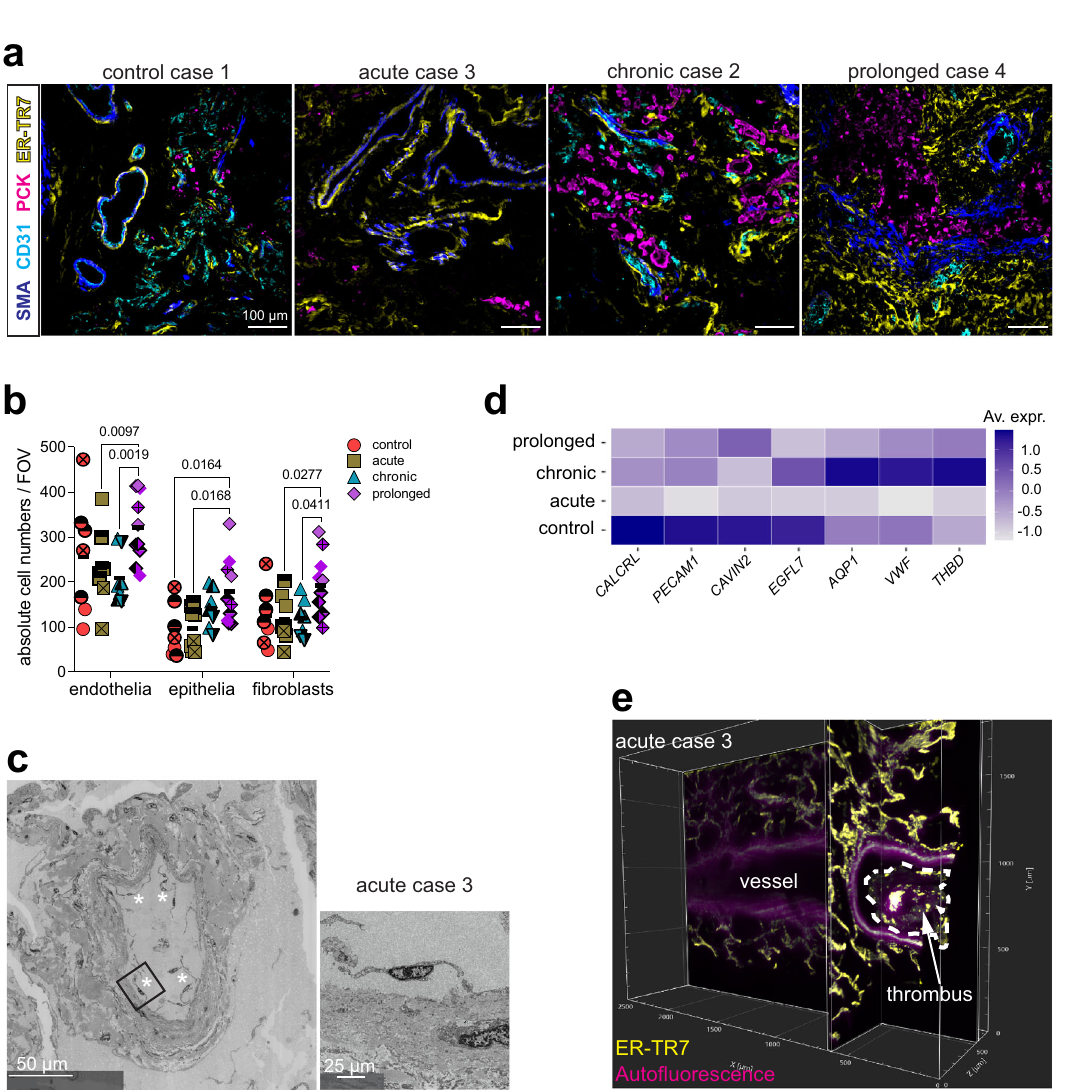
Fig.2|EndothelialdysfunctioninsevereacuteCOVID-19isanindirecteffectof SARS-CoV-2 infection. a Multiplex microscopy immuno fl uorescence (IF) images depictingsmoothmuscleactin( α SMA)inblue,CD31incyan,pancytokeratin(PCK) in magenta and ER-TR7 in yellow in one representative fi eld of view (FOV) in lung tissue for each disease group. b Dot plot of the absolute cell numbers per FOV of endothelial cells, epithelial cells and fi broblasts in each disease group. Various fi lled-symbols represent distinct donors. Data (M±SD) are analyzed by two-way ANOVAwithFisher ’ sLSDtest, F (3,84)=8.124, p ˂ 0.0001.Sourcedataareprovided asaSourceData fi le.( a,b )( n =32FOVs).SeealsoSupplementaryFigs.1Band2A – C. c Ultrastructural image of autopsy lung tissue from one acute donor shows a large